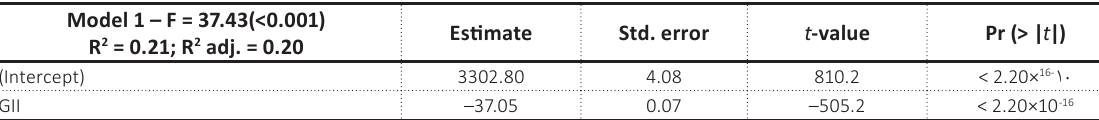
Figure 1. Relationship between GII and G_Tob Table 3. Regression analysis – model 1